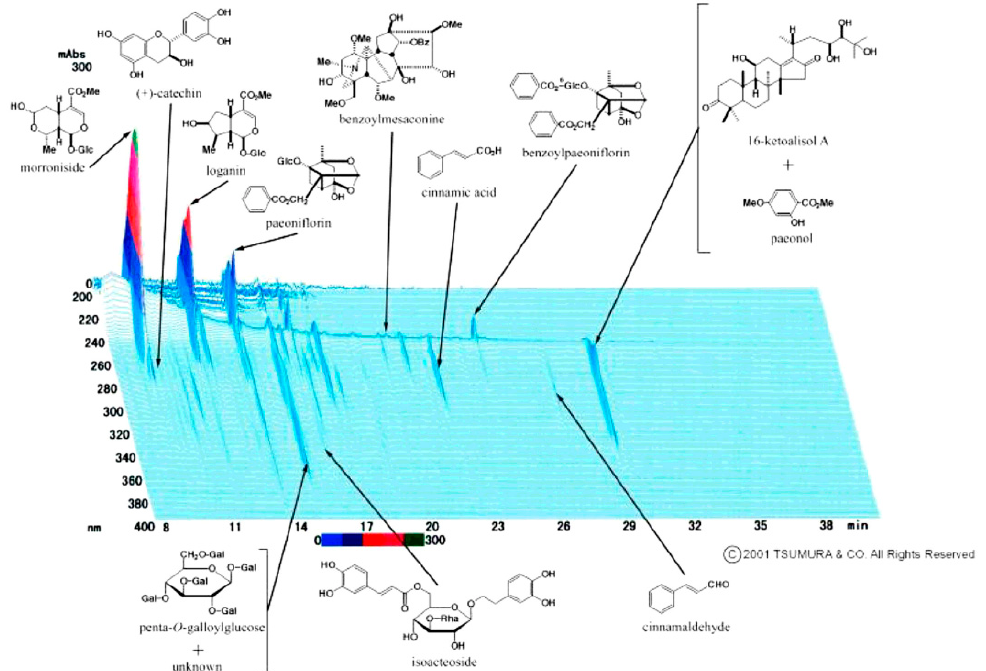
Figure 1. Three-dimensional high-performance liquid chromatography profile of Gosha-jinki-gan. Gal: galloyl.